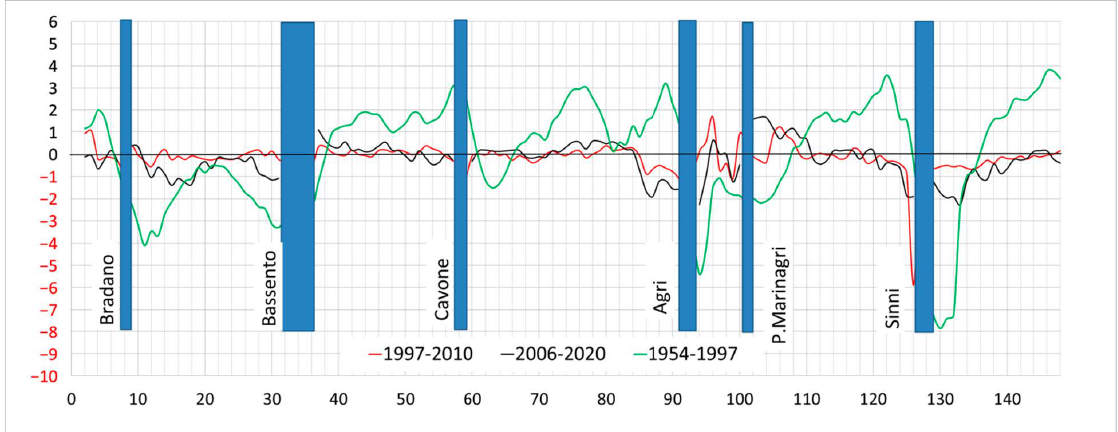
Figure 6. Shoreline evolution (in m/yr) at three different periods: from 1954 to 1997, from 1997 to 2010 and from 2006 to 2020. The blue polygons represent the fluvial areas (no data). The numbers indicate the transects from North to South.